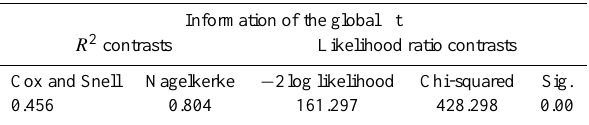
Table 3. Parameters of the global fit of the model for the CM. Chi- squared test for − 2LL reduction and several R 2 measures.